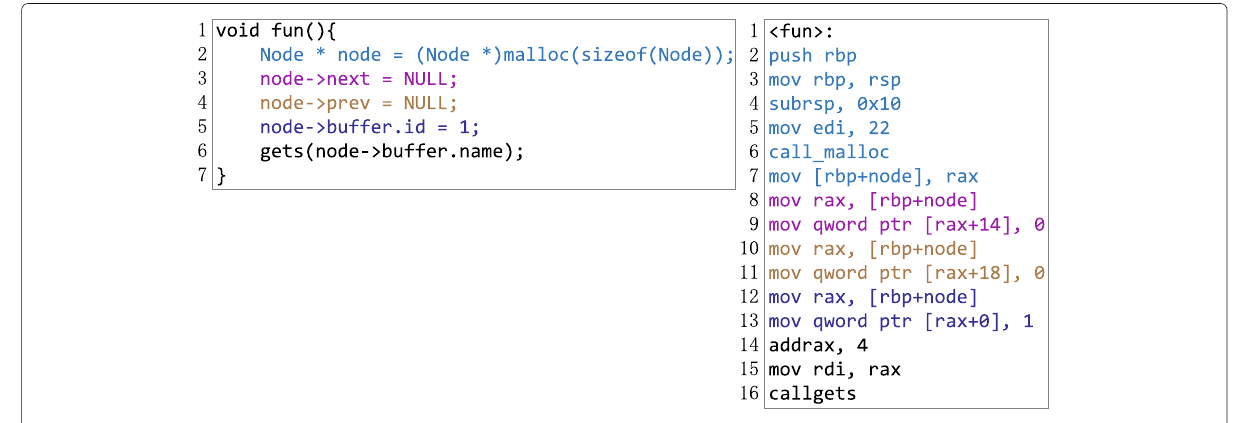
Fig. 8 The source code and assembly code of initializing the linked list node